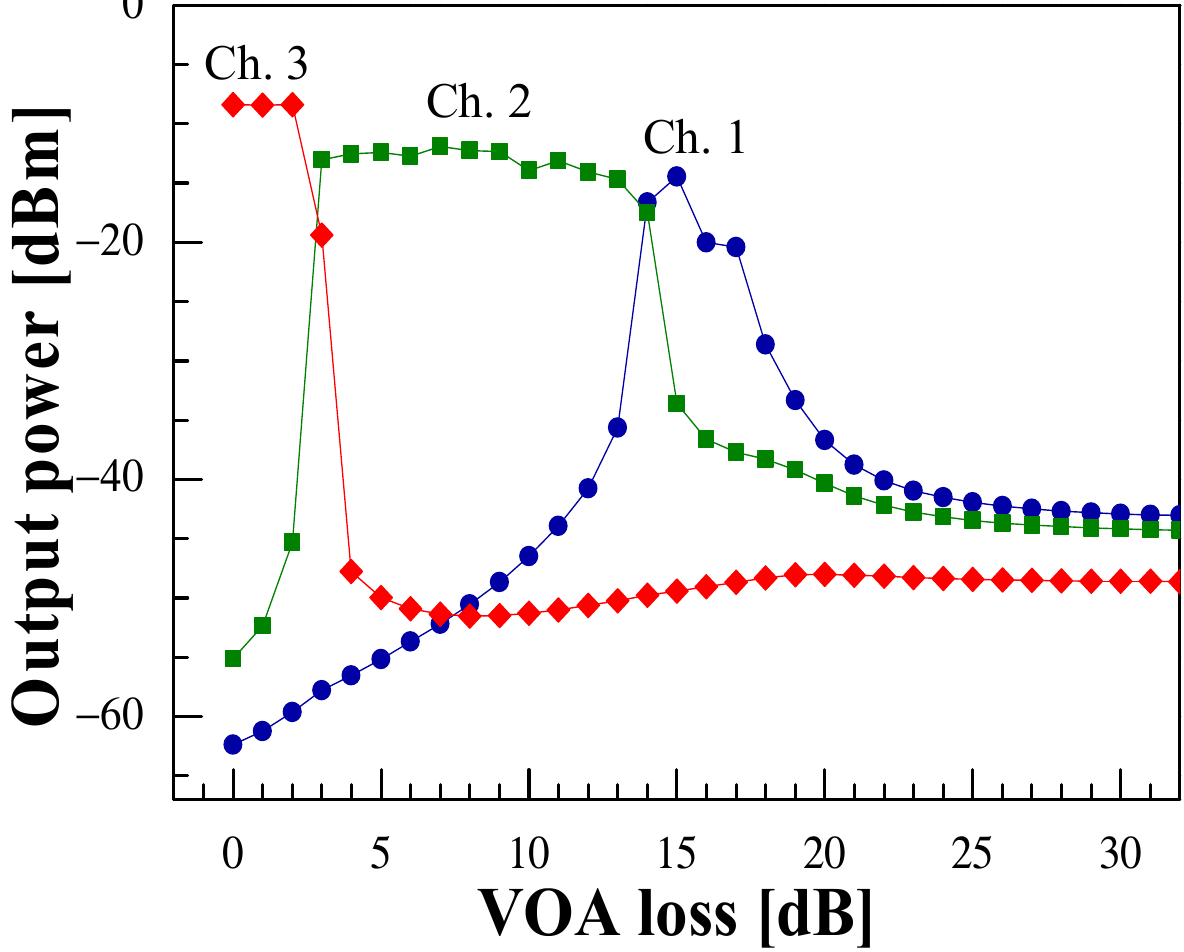
Figure 3. VOA loss-dependent output power at peak wavelengths of channeled spectra for Ch. 1 (blue circle), Ch. 2 (green square), and Ch. 3 (red diamond).